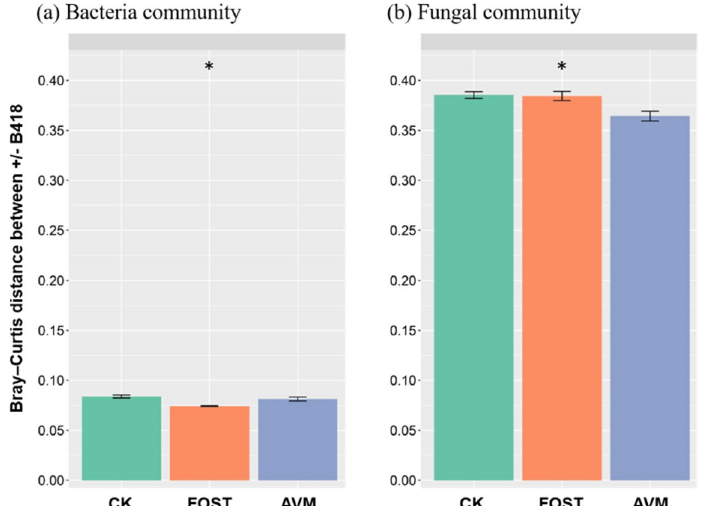
Figure 2. The relative abundance by Bray–Curtis distance of ( a ) bacterial community and ( b ) fungal community in the rhizosphere of different treatments with Burkholderia vietnamiensis B418 inoculation. Error bar indicates standard error at P = 0.05 in the ANOVA test for microbial content. CK: control; FOST: fosthiazate; AVM: avermectin.